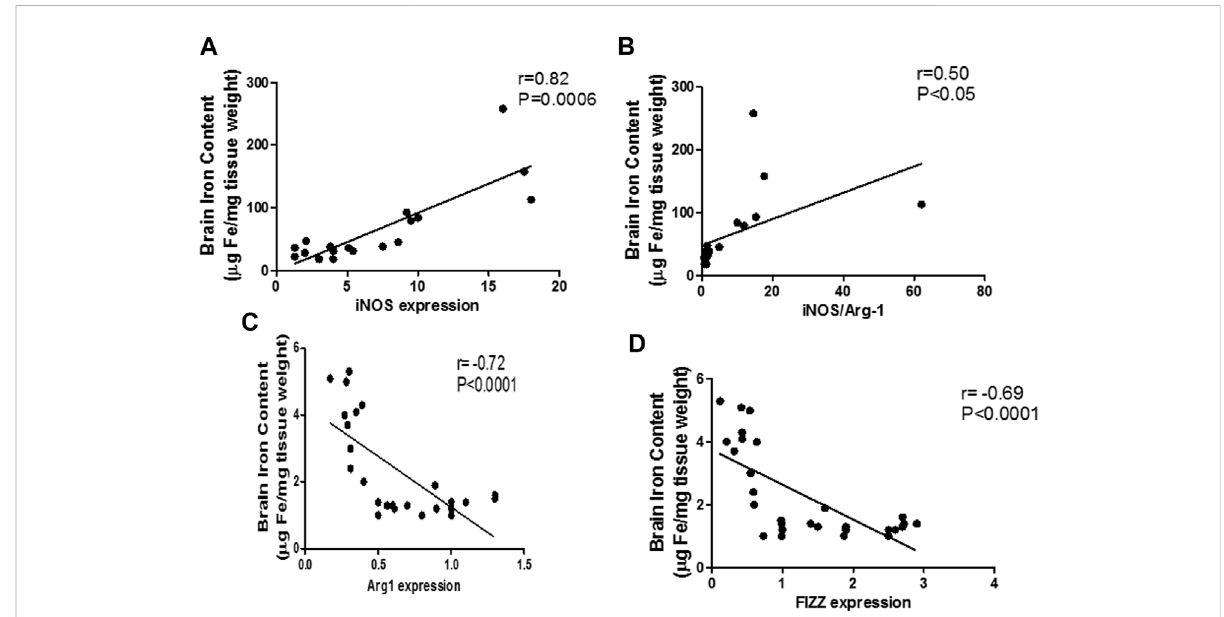
FIGURE 10 Linear regression analysis between brain iron levels and pro-in fl ammatory macrophage (M1) polarization markers. Signi fi cant positive correlation is noticed between the brain iron levels and the pro-in fl ammatory markers: iNOS (A) and iNOS/Arg-1 ratio (B) . Signi fi cant negative correlation is noted between brain iron level and the anti-in fl ammatory markers Arg-1 (C) and FIZZ (D)